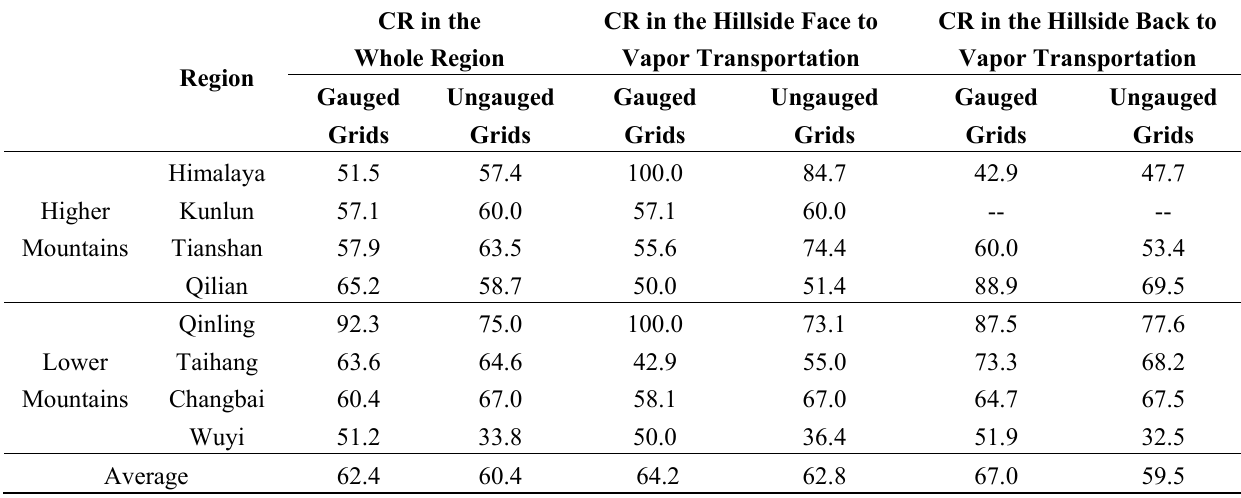
Table 3. Consistency rate (%) of mean annual rainfall (2001–2012) of the original 3B43. CR in the CR in the Hillside Face to CR in the Hillside Back to Whole Region Vapor Transportation Vapor Transportation Region Gauged Ungauged Gauged Ungauged Gauged Grids Grids Grids Grids